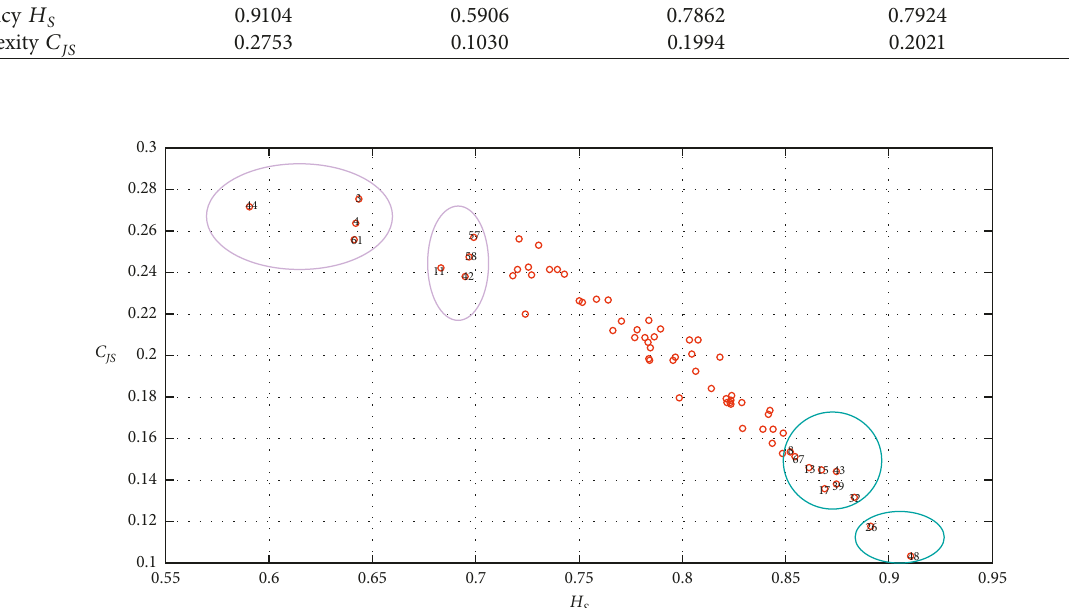
Figure 6: Complexity-entropy binary causal plane of Chinese real estate